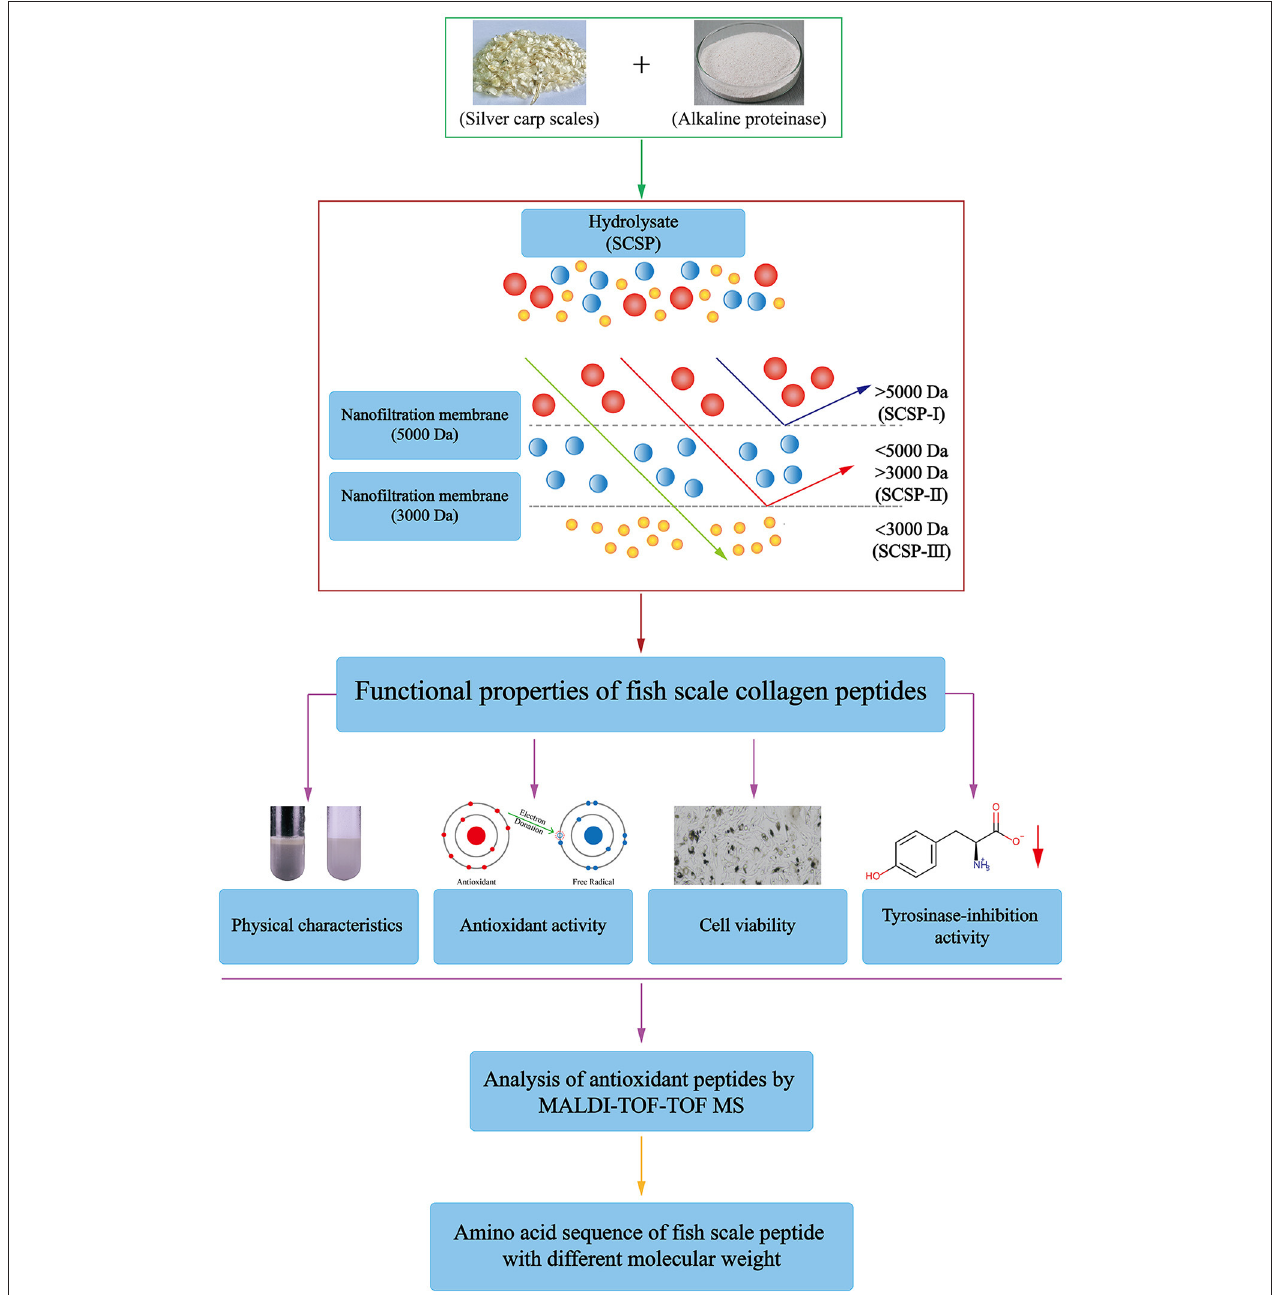
FIGURE 1 | Technical roadmap for the preparation and analysis of